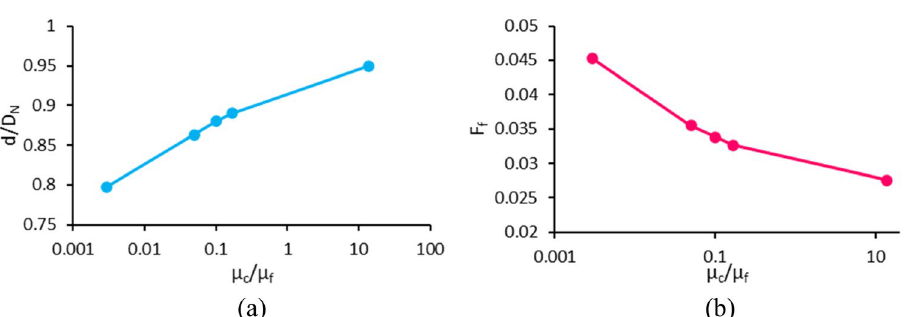
Figure 20. Variation of ( a ) the dimensionless droplet diameter and ( b ) the formation frequency in terms of the continuous phase to ferrofluid viscosity ratio (the x-axis is plotted in a logarithmic